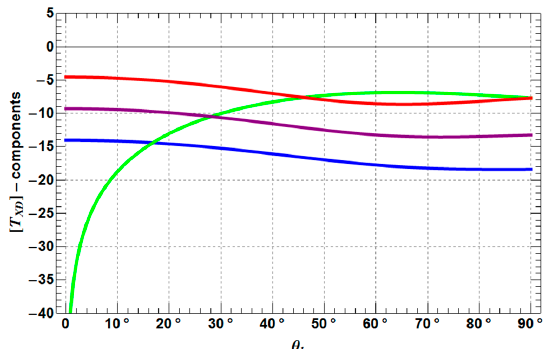
Figure 4. Sensitivity of coherency matrix elements T XD11 (blue), T XD12 (purple), T XD22 (red) and T XD33 (green) (dB) with roughness angle θ 1 ( ε s = 20, ε t = 30, ω l = 30°, L SXD = 1, ϕ = 0°).